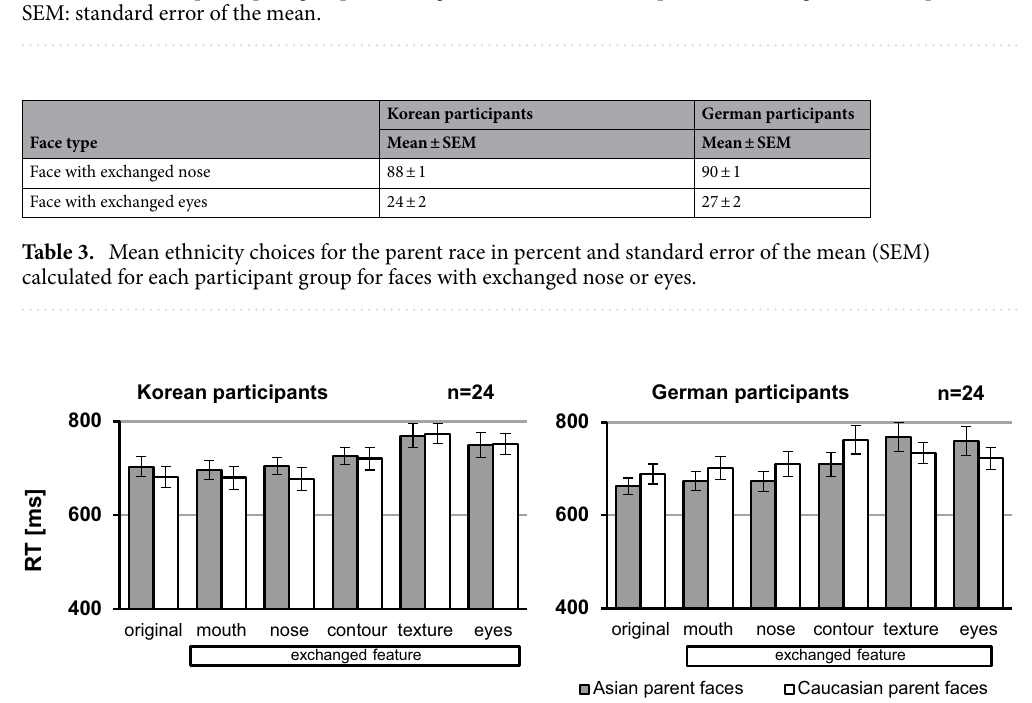
Figure 3. Response times for faces without (original) or with featural modifications (mouth, nose, contour, texture and eyes). Error bars denote standard error of the